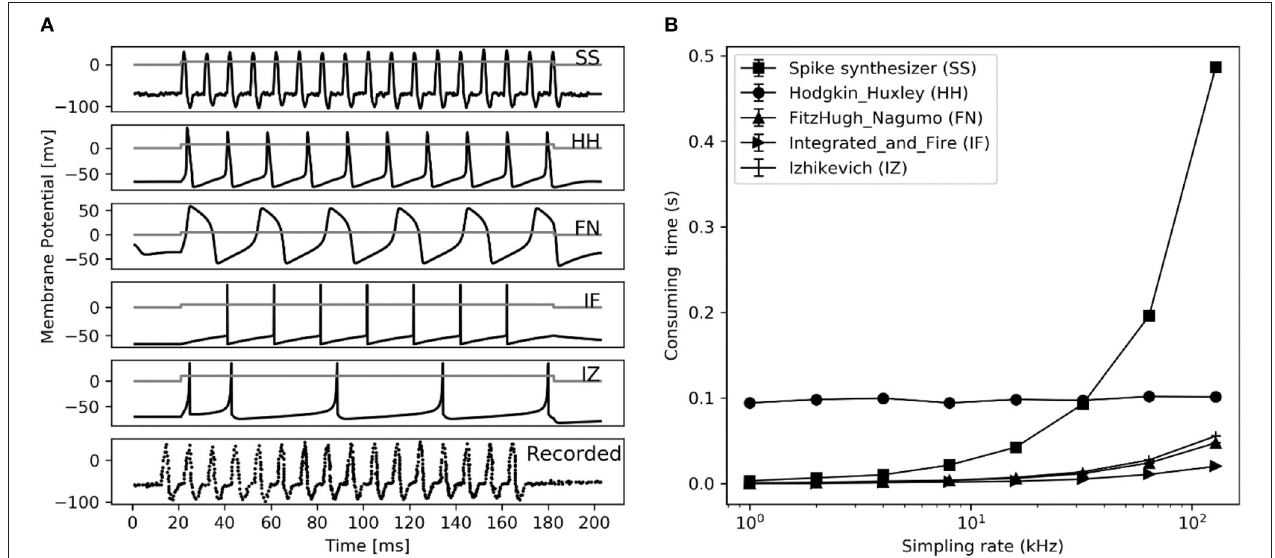
FIGURE 8 | Performance comparison between different spiking neuron models. (A) Reproduction of spiking waveform (200ms frame) using our spike synthesizer and previous neuron models (from top 1 to 5th trace), their applied current ( i a , nA) is shown in gray curve in each simulated trace. The recorded typical spiking waveform reprinted from Hodgkin et al. (1952), are depicted in bottom. (B) Consuming time of converting applied current into action potential for simulation in left figure at different sampling rate using different neuron models. Error bars represent the standard deviation.